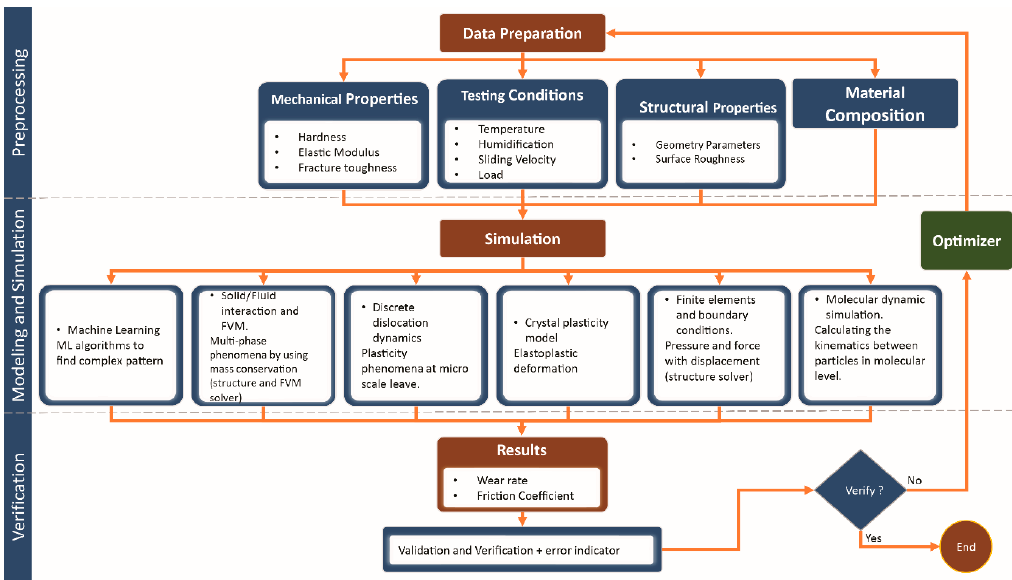
Figure 1. Overview of different simulation techniques commonly used in tribological related